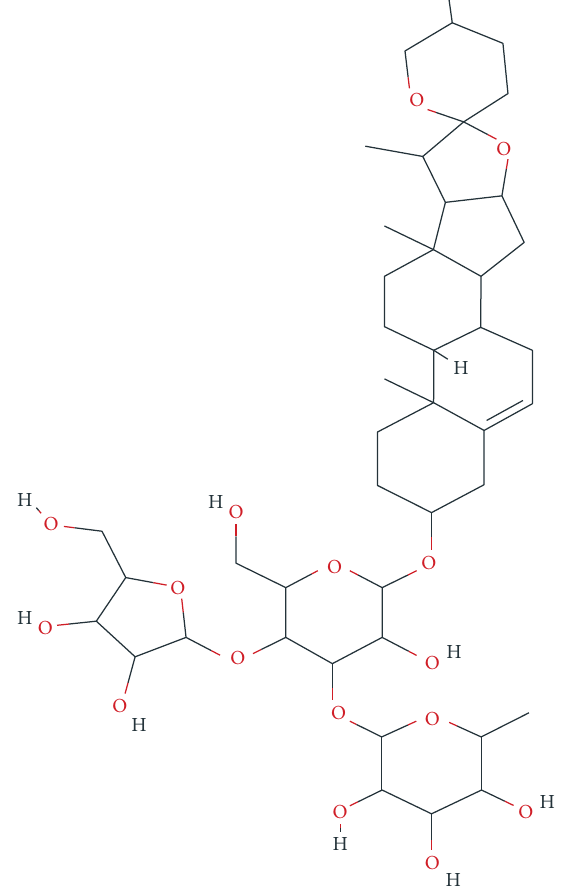
Figure 1: The molecular structure of PP2.